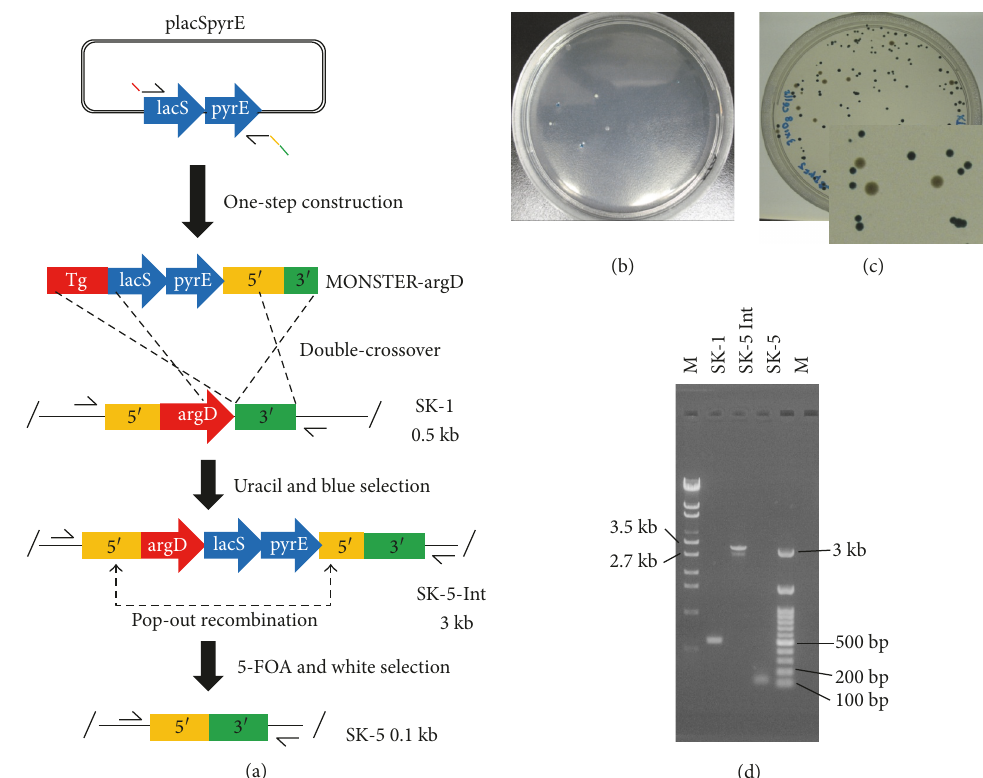
Figure 5: In-frame deletion of argD via the MONSTER. (a) Construction of an argD deletion mutant. A plasmid-borne pyrE - lacS marker served as the PCR template, which attached S. acidocaldarius chromosomal sequences (5 ′ , 3 ′ , and partial sequences of argD at the 5 ′ ends of the primers) to the ends of the selectable dual marker. After one-step construction, the MONSTER-argD was electroporated into strain SK-1. A double crossover between the MONSTER-argD and the chromosome at the Tg and 3 ′ regions results in the pyrE - lacS marker and 5 ′ region insertion at the argD locus. The resulting uracil prototroph transformants exhibit blue colonies and can be selected on uracil-free plates. An argD deletion mutant with the marker removed was generated by pop-out recombination at two duplicated 5 ′ regions, which can be selected by 5-FOA counterselection in combination with X-gal staining. Arrows show the positions of PCR primer sets. (b) Uracil and blue selection plate. (c) 5-FOA and white selection plate. (d) PCR analysis of the argD locus of the S. acidocaldarius strains SK-1 ( Δ pyrE Δ suaI ), SK-5 Int (intermediate), and SK-5 ( Δ pyrE Δ suaI Δ argD ) using argD-F-F/R as primers. The expected sizes of the PCR bands were 0.5kb (wt), 3kb (recombinant), and 0.1kb (deletion mutant). A λ -EcoT14 or 100 bp DNA ladder was loaded in lane M.